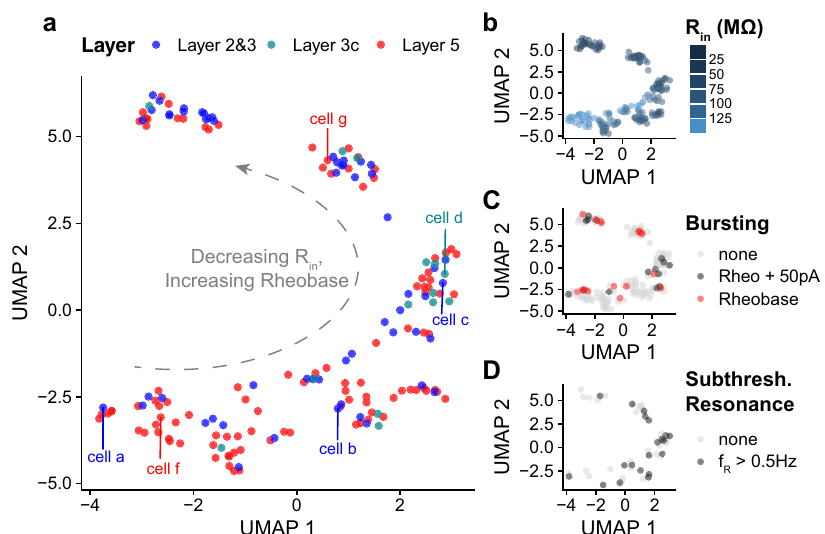
Fig. 6 Dimensionality reduction reveals considerable intrinsic electrophysiological similarity and overlap between pyramidal cells recorded in different layers. a Dimensionality reduction analysis performed on multivariate sets of electrophysiological features using uniform manifold approximation (UMAP). Neurons are arranged by similarity in intrinsic electrophysiological features (see “ Methods ” for list of features used in analysis). Cell counts: L2&3: n = 56, L3c: n = 14, L5: n = 103 neurons. Cell labels correspond to neurons whose morphologies are highlighted in Fig. 1. b – d Same as a , but neurons are colored by input resistance ( b ), bursting behavior ( c ), or subthreshold resonance ( d ). Bursting behavior in c is broken down by neurons that show no bursting, neurons that burst at rheobase current plus 50 pA, or neurons that burst at rheobase. Bursting is de fi ned where the instantaneous fi ring rate is >75 Hz. Source data are provided as a Source data fi